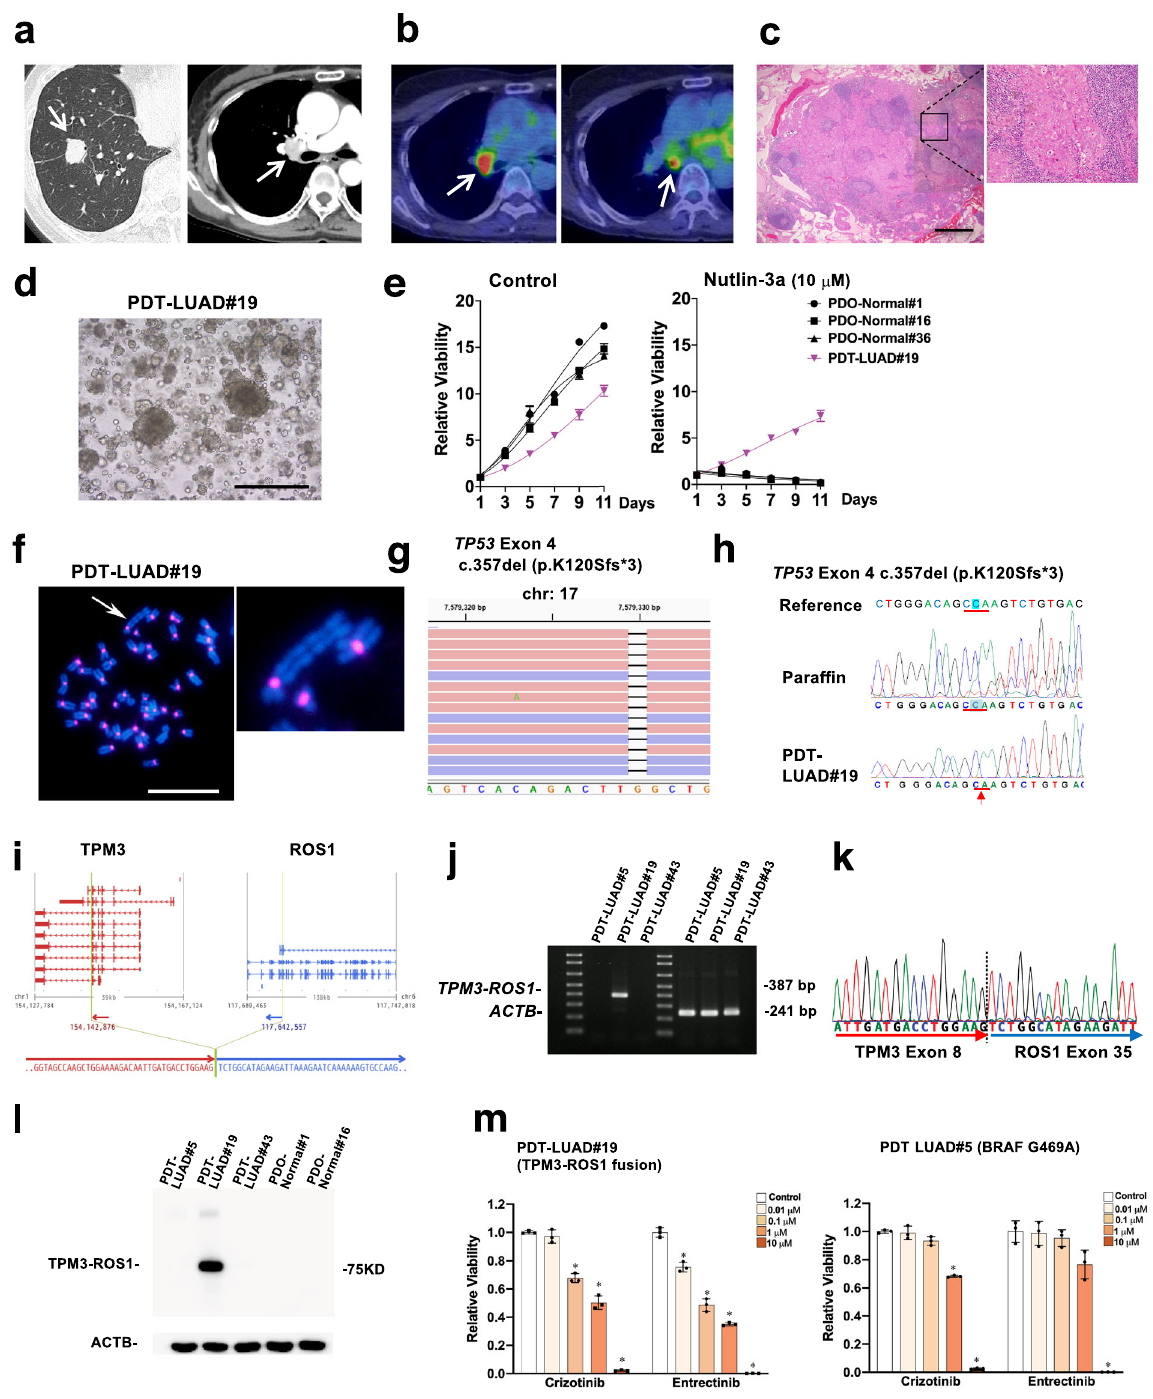
Fig. 2 Patient-derived tumoroids (PDTs) from lymph node metastasis of a metastatic lung cancer (PDT-LUAD#19). a The nodule located in the right lower lobe was found by a CT scan (white arrow, left column). Enlarged right hilar lymph node was detected by Contrast Enhanced Computed Tomography (CECT) (white arrow, right column). b Increased FDG uptake in hilar (left) and subcarinal (right) lymph nodes was observed by FDG-PET/CT (white arrow). c Malignant cells were detected in the subcarinal lymph node specimen by HE staining (magni fi ed on the right). Scale bar, 1 mm. d Shown is a bright- fi eld microscopy image of PDT-LUAD#19. Scale bar, 500 μ m. e Cell viability assays were conducted as described in Fig. 1d. f Metaphase FISH images are shown as described in Fig. 1e. An aberrant large chromosome was detected (white arrow). Scale bar, 20 μ m. g Exome-seq detected c.357del (p.K120Sfs*3) and c.91G > A (p.V31I) (not shown) in both alleles of TP53 from PDT-LUAD#19. Red and blue lines represent forward and reverse reads, respectively. h Sanger sequencing con fi rmed the exome-seq data shown in Fig. 2g. i RNA- seq detected a TPM3-ROS1 fusion from PDT-LUAD#19. The junction of the two genes was located in chr1:154,142,876 and chr6:117,642,557. j RT- PCR con fi rmed the expression of a TPM3-ROS1 transcript in PDT-LUAD#19. ACTB was used as internal control. k Sanger sequencing result of a RT- PCR product from PDT-LUAD#19 harboring a TPM3-ROS1 rearrangement was consistent with the RNA-seq result. l TPM3-ROS1 fusion protein was detected using ROS1 antibody in PDT-LUAD#19. ACTB was used as internal control. m ROS1 inhibitors (crizotinib and entrectinib) signi fi cantly suppressed the growth of PDT-LUAD#19 ( TPM3-ROS1 ; TP53 K120Sfs*3 ) at lower concentration than that of PDT-LUAD#5 ( BRAF G469A ; TP53 T155P ) 72h after treatment. Cell viability assays were performed as described in Fig. 1d. Data are shown as mean ±